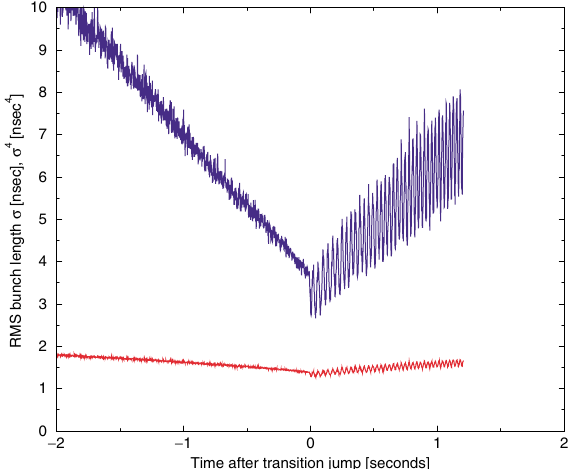
FIG. 8. (Color) Total beam intensity during the ramp in both RHIC rings. Transition crossing is indicated by a dashed FIG. 6. (Color) Measured rms bunch length # (red line) and s vertical line, as well as start and end of the ramp. (blue line) around transition in the BLUE its fourth power # 4 s ring, fill 02684. The proper times for the case before and after can be found by extrapolating the the jump when (cid:4) (cid:1) (cid:4) t data to the points of zero bunch length. This is measured # 4 s the case at (cid:2) 1 : 1 s and (cid:7) 1 : 1 s , respectively. Since the actual jump occurs at 0.0 s, this indicates a symmetric jump. Longitudinal quadrupole oscillations after the jump are due to mismatched timing of the rf phase flip with respect to the (cid:4) t quadrupole polarity